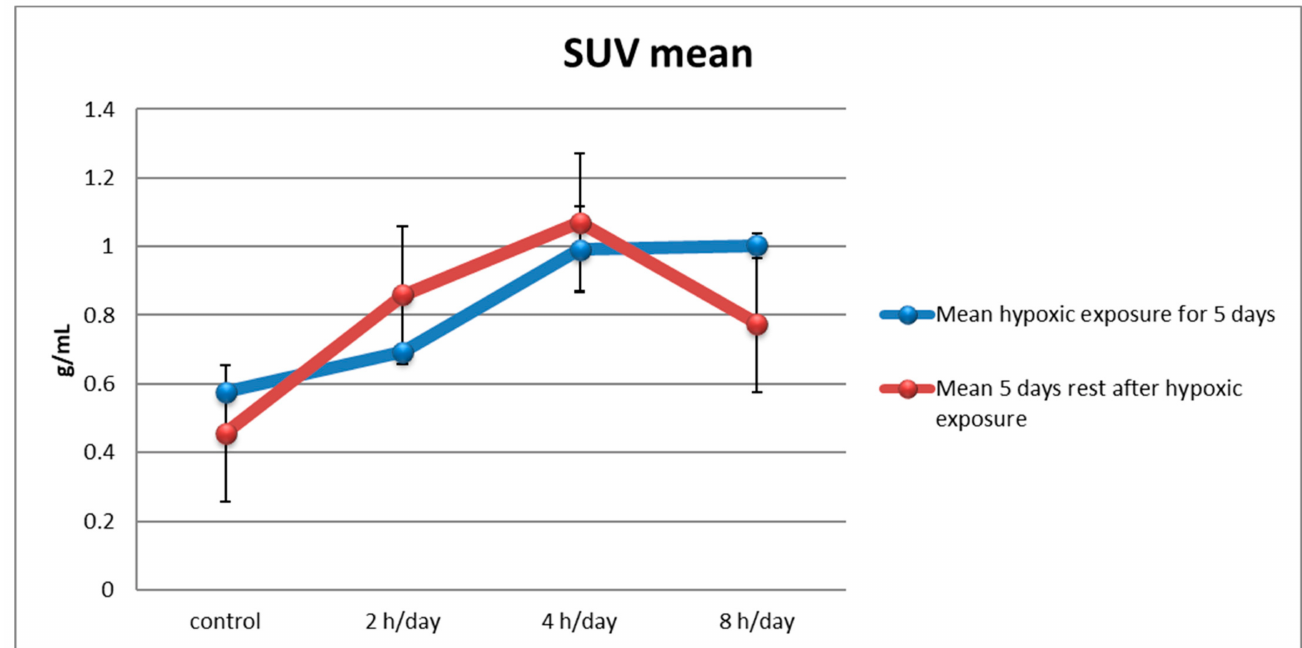
Figure 3. Brain metabolism using small-animal PET/CT imaging. After exposure to 10% O 2 for one week, the mean SUV was elevated in the 4 and 8 h per day groups compared with the control group ( p = 0.000). Next, all rats were subjected to normal conditions for one week; the mean SUV was elevated in the 2 4 h per day groups compared with the control group ( p = 0.047). The mean SUV was decreased in the group with an exposure time of 8 h per